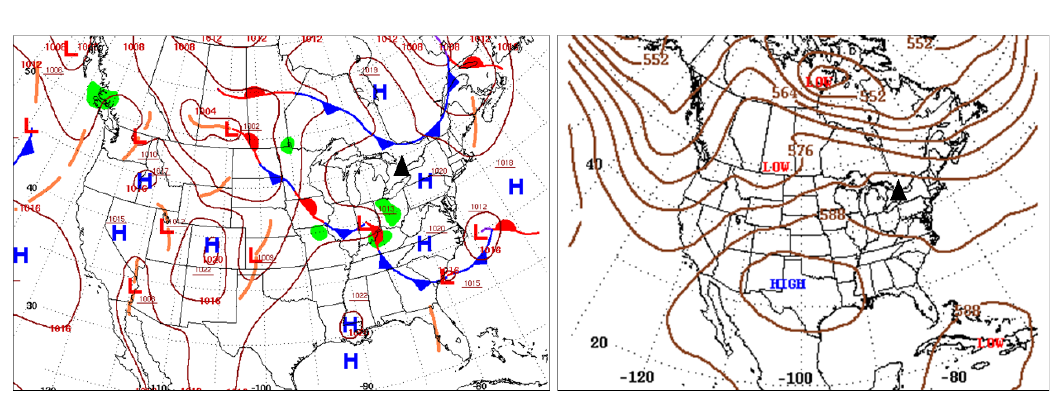
Figure 9. Panel ( a ) is the NCEP surface reanalysis map for 12 July 2015 at 07:00 EST. Panel ( b ) is the 500 hPa height contour. The solid triangle represents the study region. The NCEP analysis is compared to the 10-km GEM analysis in the